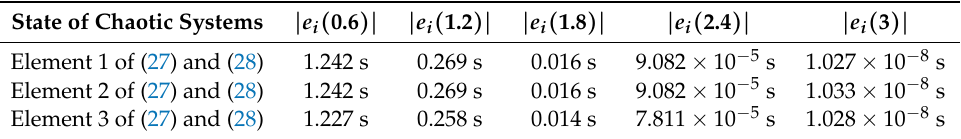
Table 2. Absolute values of errors between two identical autonomous chaotic systems (27) and (28) equipped with controller (6) via the proposed SEZN approach at different time instants during the rejection of chaotic